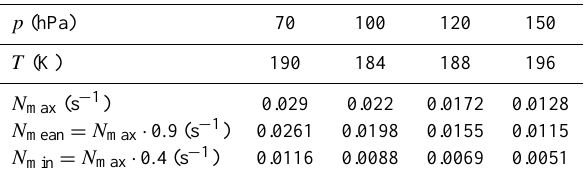
Table 1. Settings for realistic simulations to be fulfilled at ice nu-